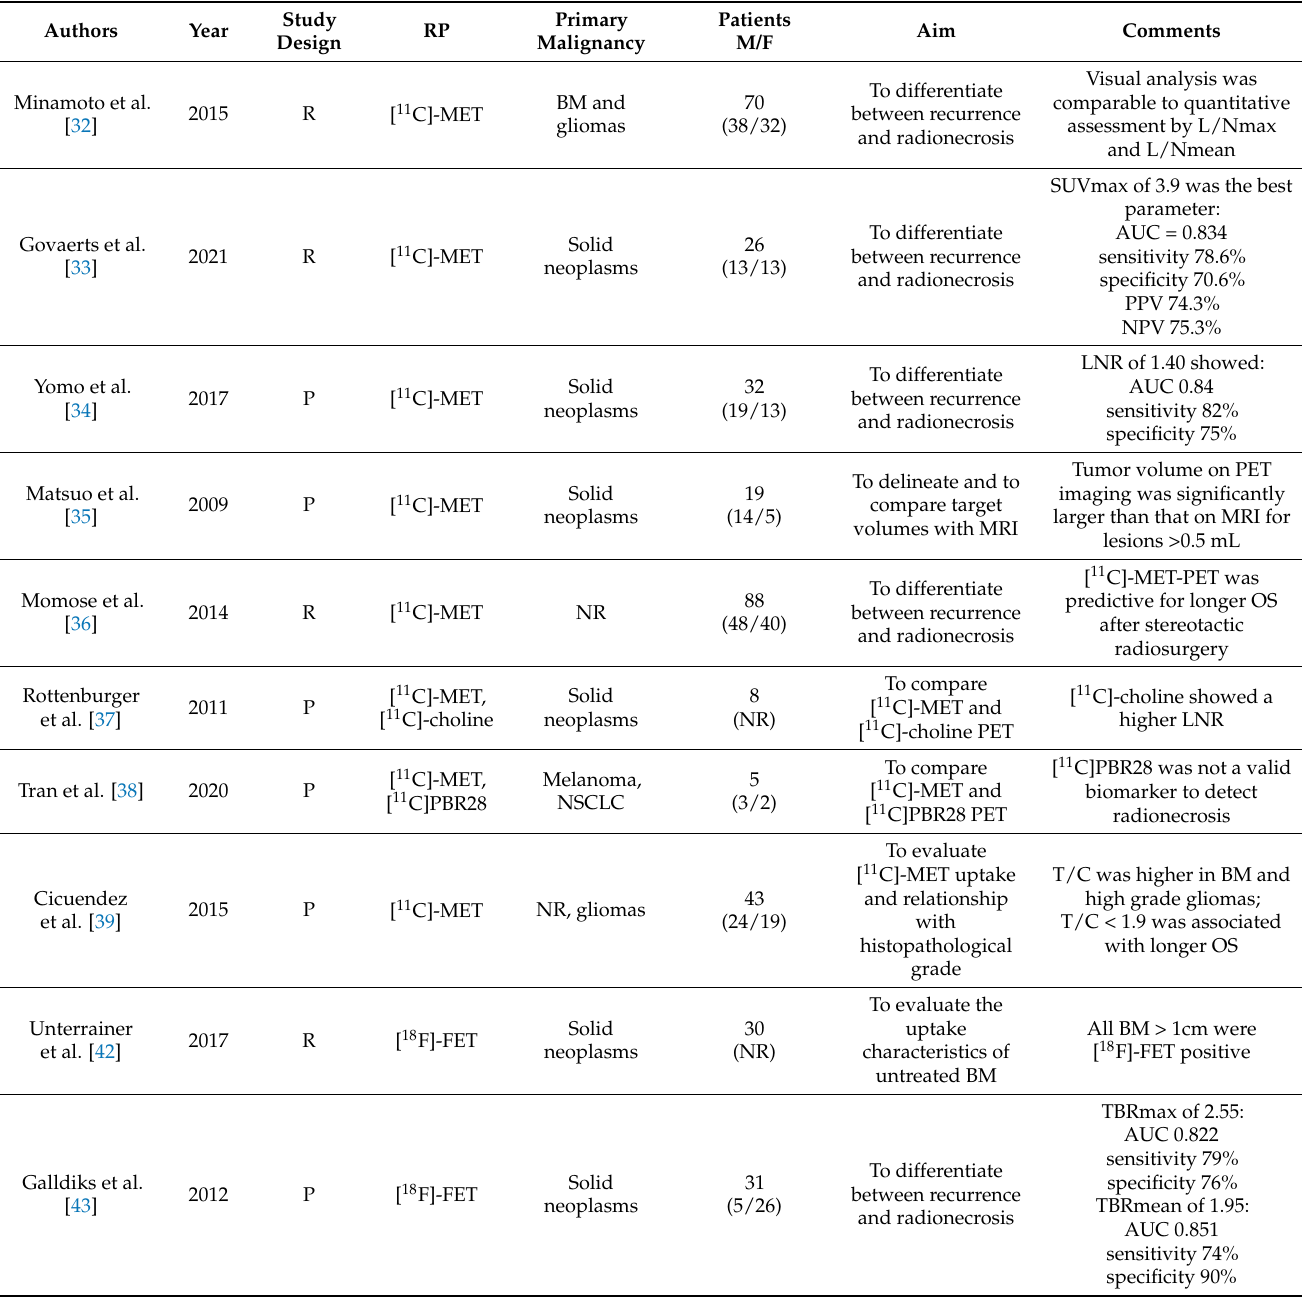
Table 2. Summary of general characteristics for studies with amino acids